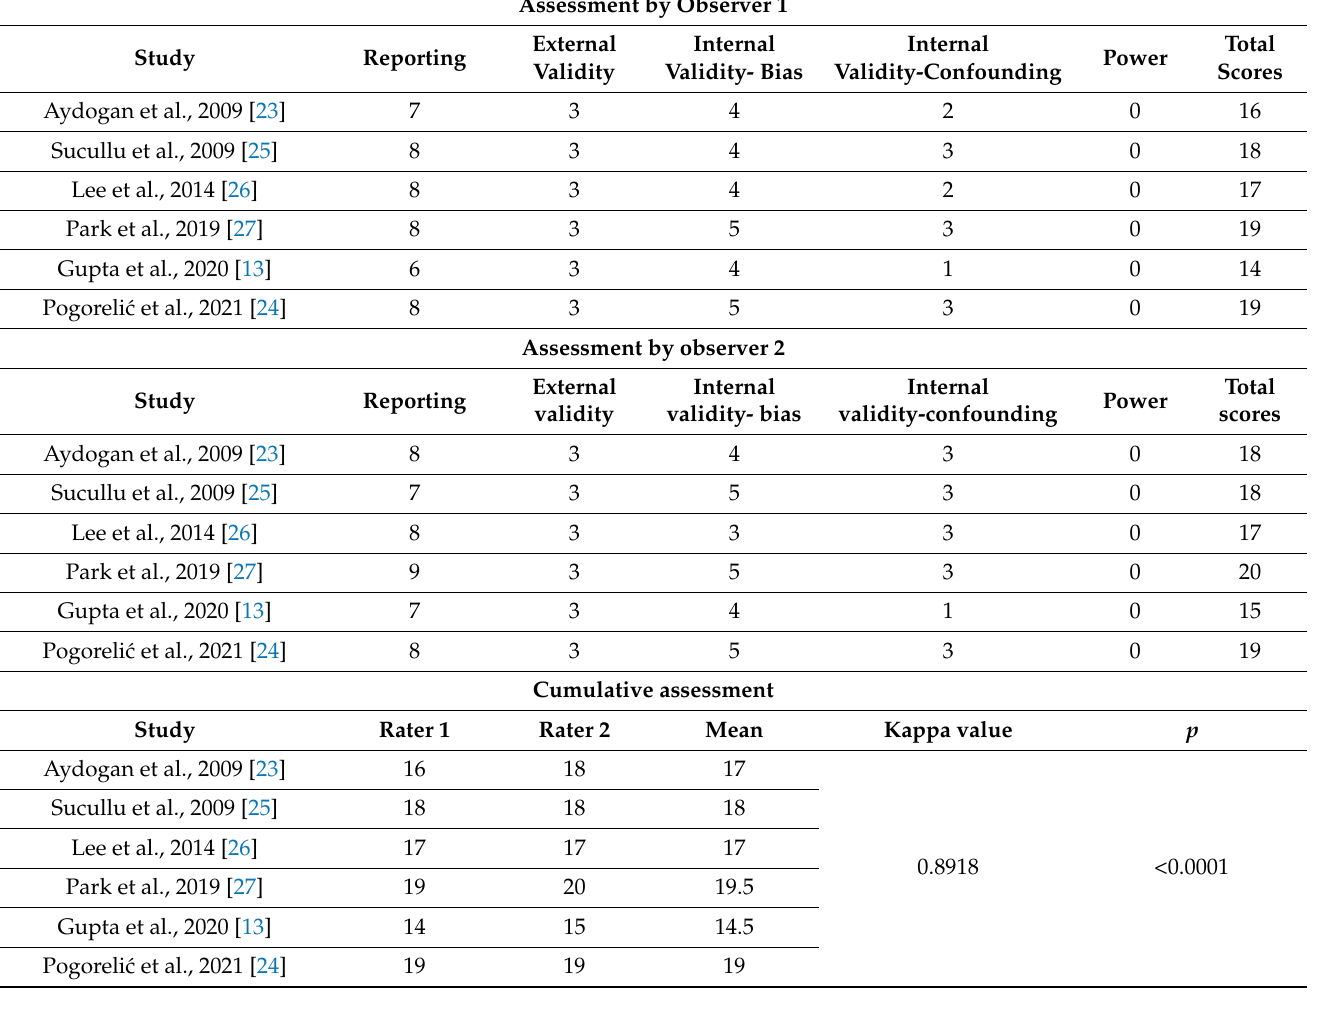
Table 2. Independent methodological quality assessment by two observers utilizing the Downs and Black